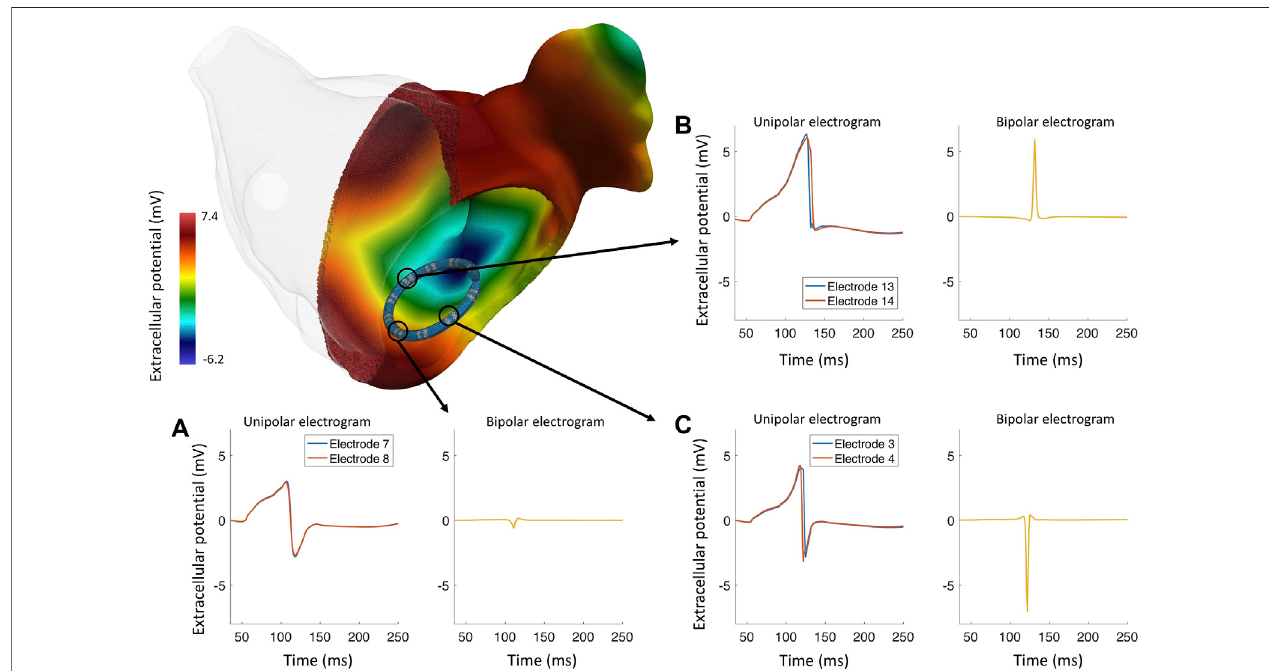
FIGURE 2 | Bidomain simulation of a realistically deformed LASSO ™ (Biosense Webster) catheter in a left atrium to study the genesis of different EGM morphologies in healthy myocardium. (A) The wavefront approaches the electrode pair 7 – 8 and activates both electrodes at the same time, the resulting bipolar electrogramwithareducedpeak-to-peak amplitude(0.42 mV). (B) Severalwavefrontsapproachingelectrodepair13 – 14,bothunipolarelectrogramsareasymmetrical, lacking an S-peak; the resulting bipolar electrogram has a high peak-to-peak amplitude and a positive polarity. (C) The wavefront travels almost perpendicular to electrode pair 3 – 4; the electrodes are activated at different times, the resulting bipolar electrogram has negative polarity and a high peak-to-peak amplitude (7.45 mV).